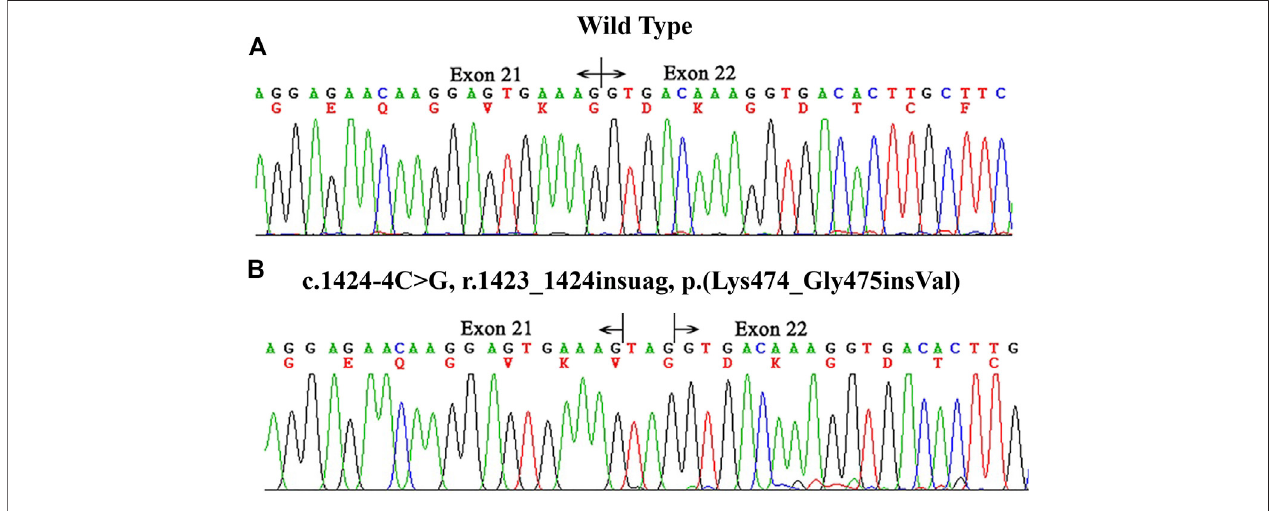
FIGURE 2 | cDNA sequencing results of COL4A5 in the proband of family X1. (A) the wild type. (B) the proband (II-3). The hemizygous variant c.1424 – 4C > G p.(Lys474_Gly475insVal) altered the 3 ′ splice site of exon 22 and resulted in an insertion of three nucleotides between exons 21 and